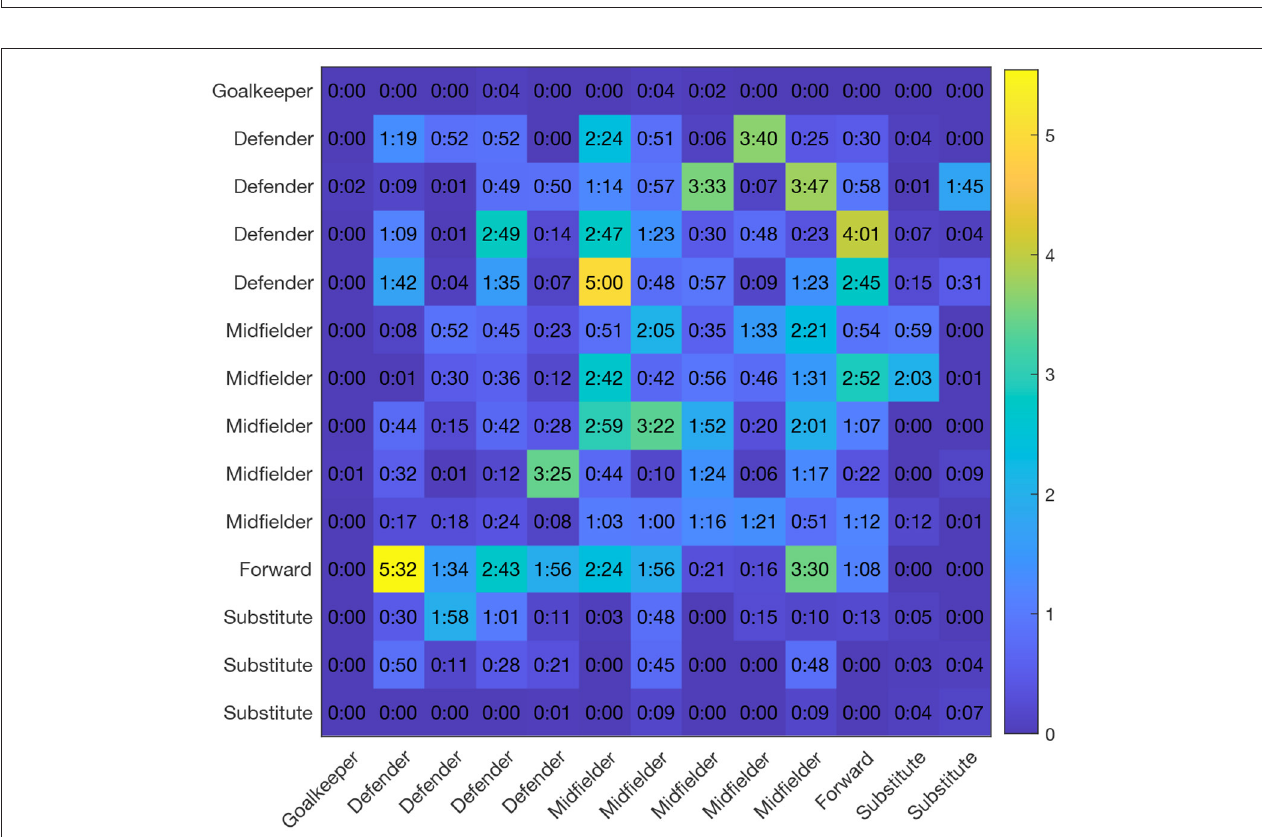
FIGURE 2 | Accumulated time with the rival players t rivals accum ( i , j ). For the same match of Figure 1 , we counted the time each player had been closer than D = 2 m to an opponent. Elements of the matrix indicate min and sec. Each player was tagged according to his position in the team: (1) goalkeeper, (2) defender, (3) midfielder, (4) forward, and (5) substitute. We can observe how the time in the risk zone is quite heterogeneous, ranging from zero sec to five and a half min.